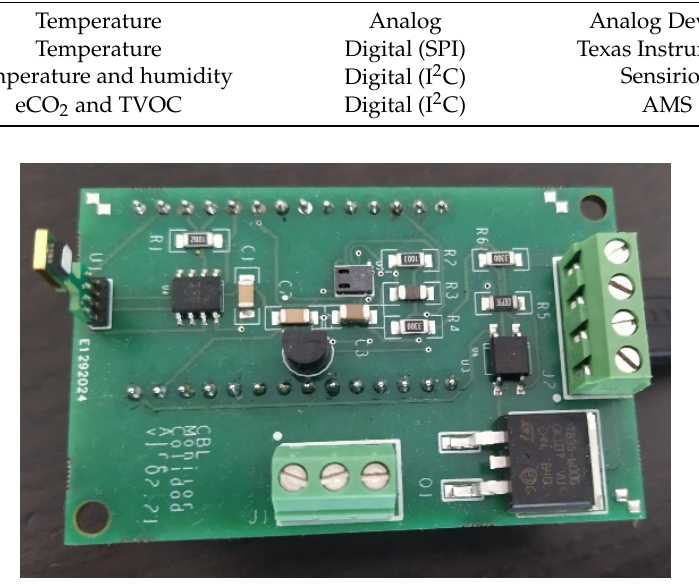
Figure 4. Designed PCB for the smart IEQ sensor node.